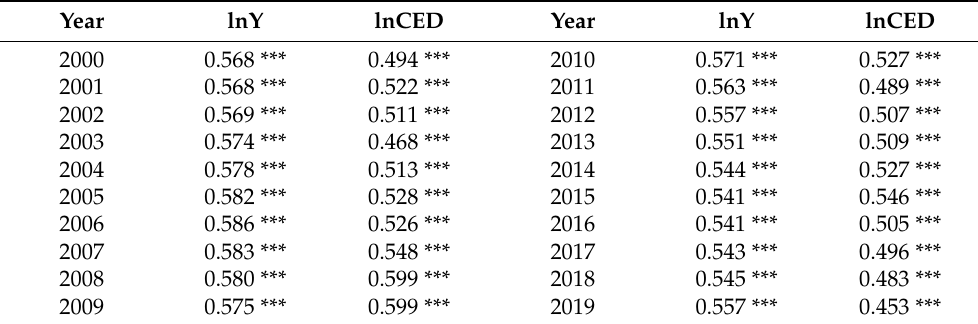
Table 3. Moran’s I value of EG and CED for 2000–2019.